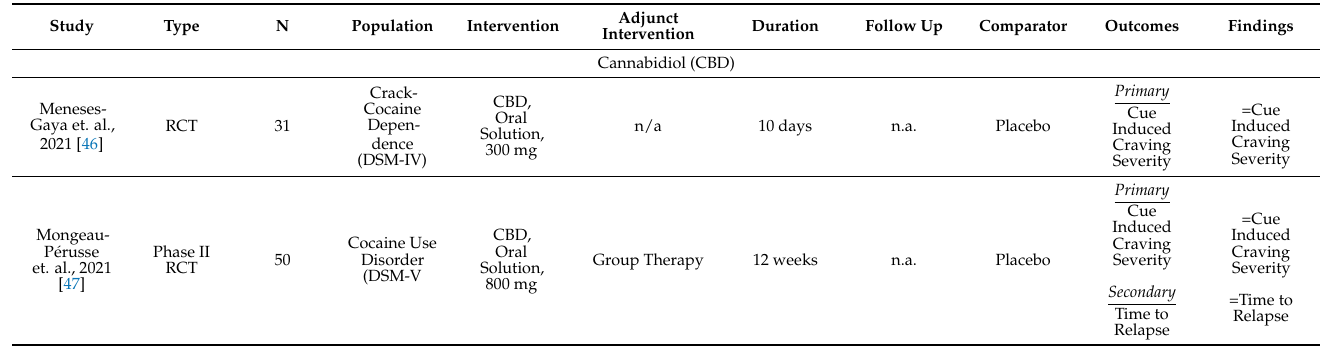
Table 6. Primary Studies pertaining to Cocaine Use Disorder.